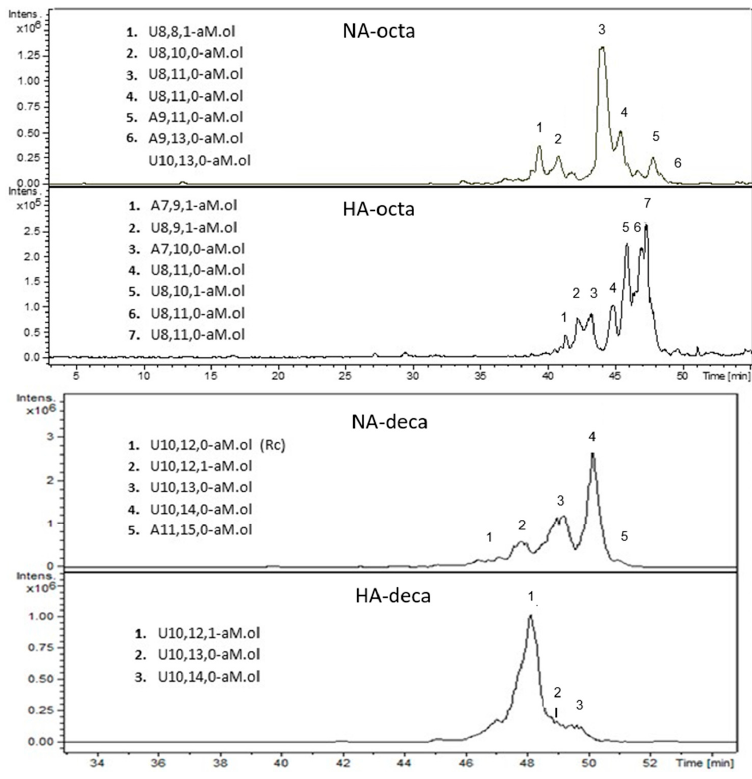
Figure 7. LC-MS profiles (BPC) of HA and NA components of octa- and decasaccharide fractions. Mass signals assignment of the main components is reported. LC elution conditions: isocratic at 20% Solvent B for 20 min, gradient elution from 20% B to 40% B for 10 min followed by a 20 min gradient from 40% B to 90% B; subsequently, 90% B was kept for 10 min.